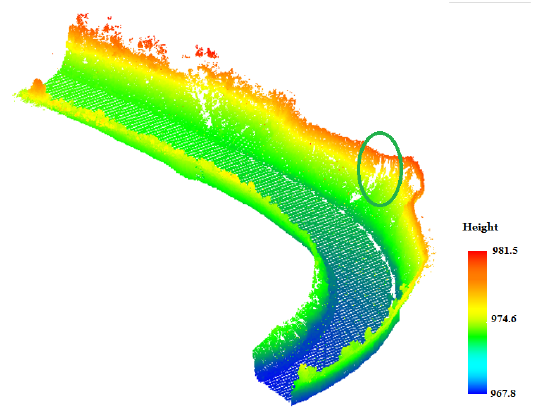
Figure 5: Original LMMS point cloud data in a 3D side view